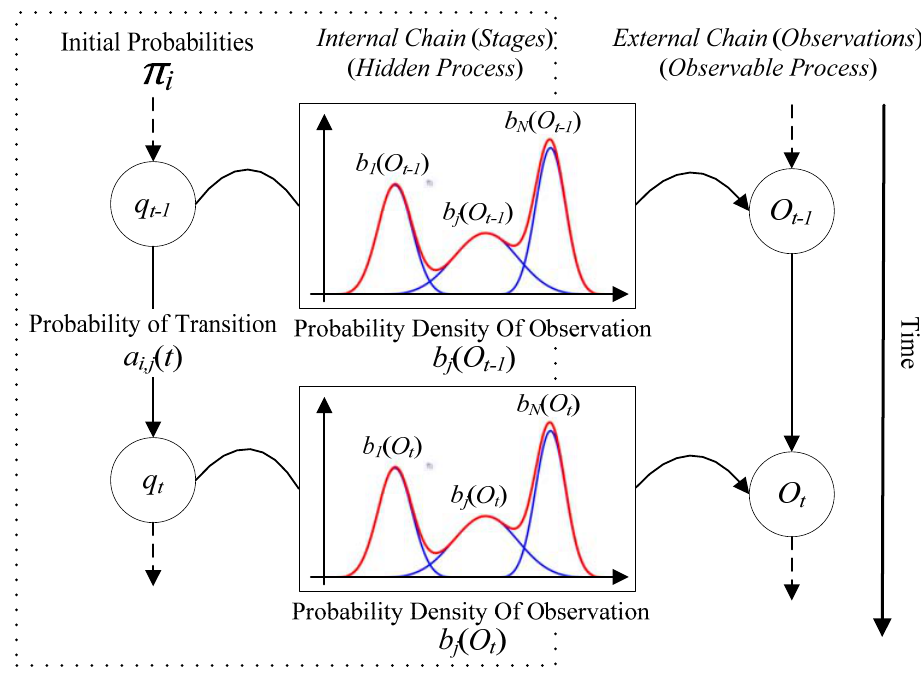
Figure 3. Basic principle of proposed Hidden Markov Model